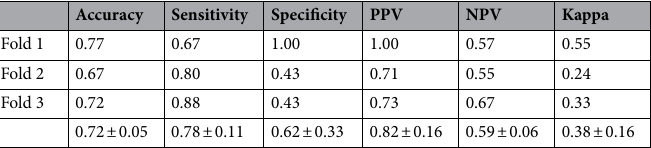
Table 2. Diagnostic values of clinical characteristics in predicting recent COVID-19.